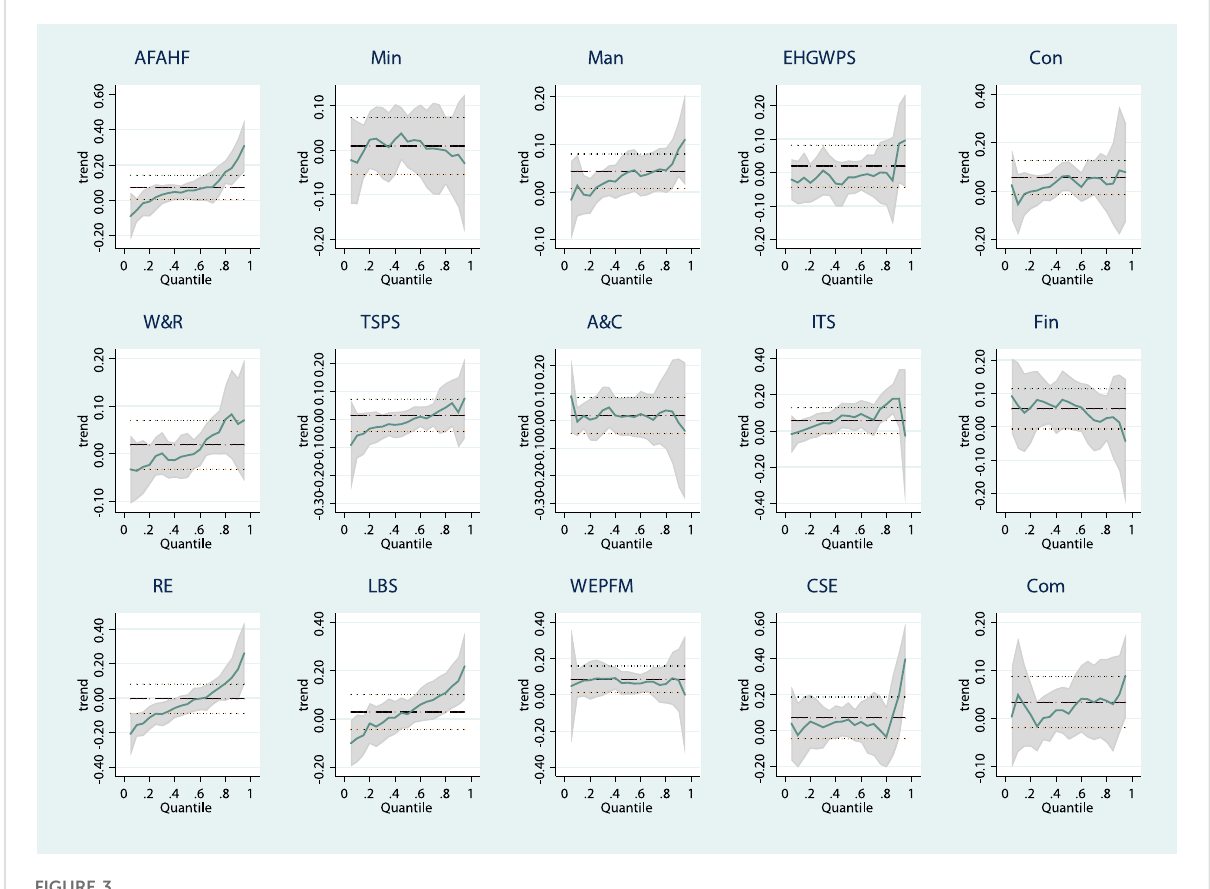
FIGURE 3 Quantile slope coef fi cients of Trend . The blue line is the coef fi cient values of Trend , and the shadow is the corresponding 95% CI. The dotted line is the coef fi cient value of ordinary least square estimation of Trend and its corresponding 95%